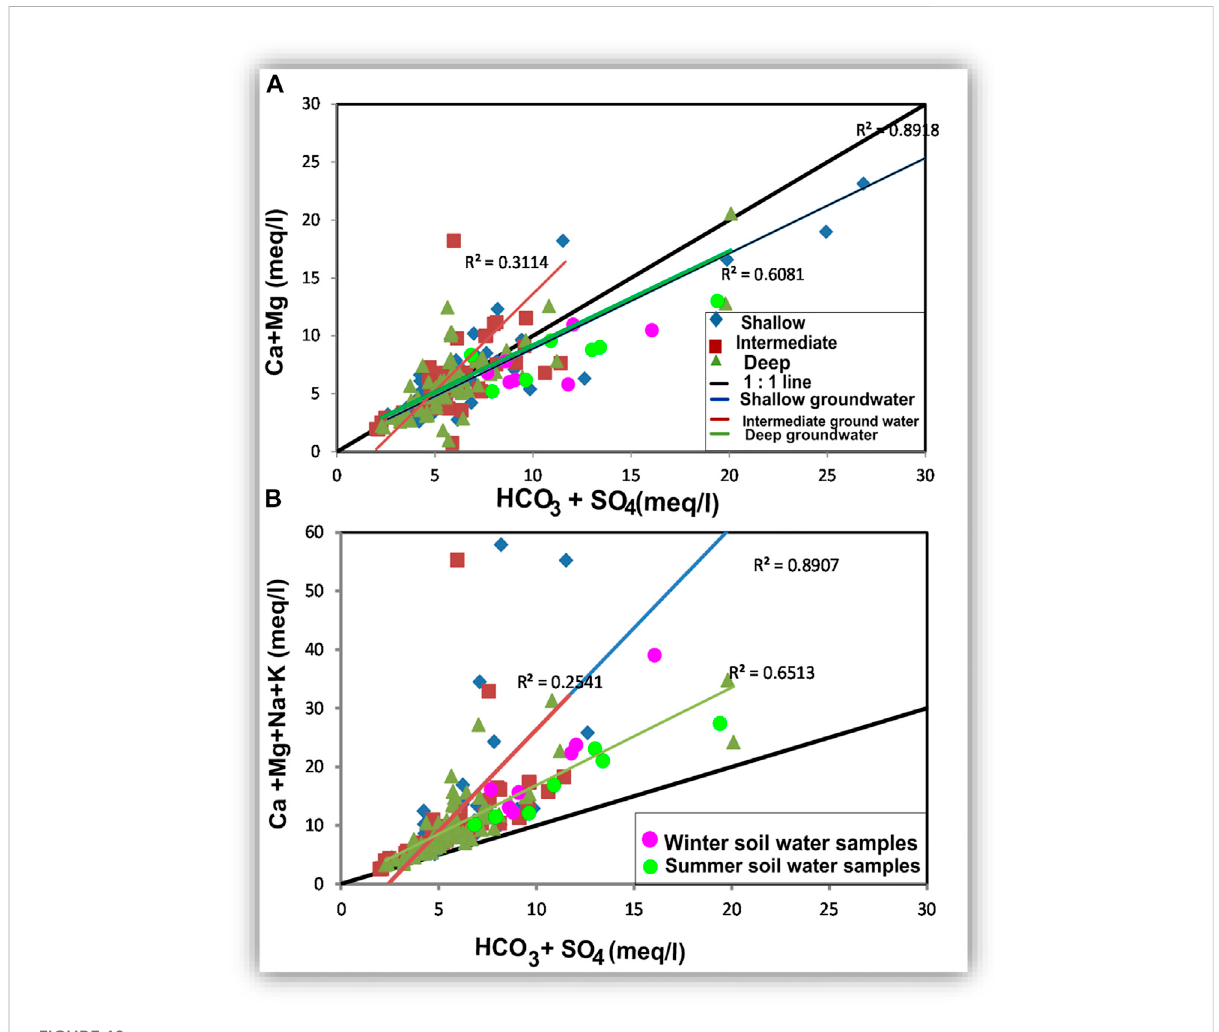
FIGURE 19 Relationships showing the role of sodium in forming salts with SO 4 and HCO 3 by replacing Ca and Mg in the dissolved sulfate and carbonate